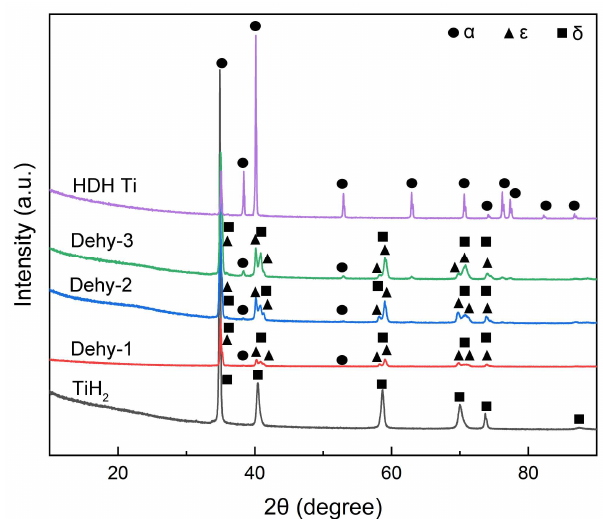
Figure 3. XRD patterns of the TiH 2 , Dehy-1, Dehy-2, Dehy-3 and HDH Ti powders. Table 3. Crystallographic data of the TiH 2 , TiH X , and HDH Ti powders based on Rietveld refinement analysis.